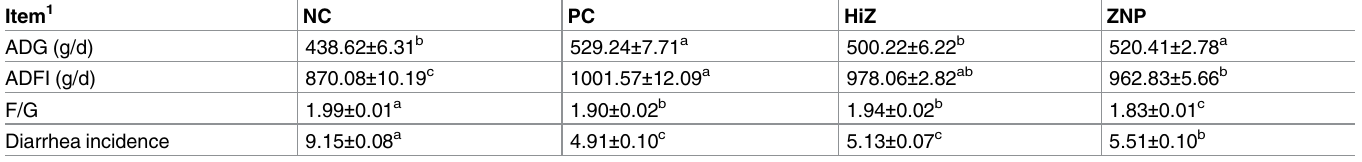
Table 3. Growth performance and the incidence rate of